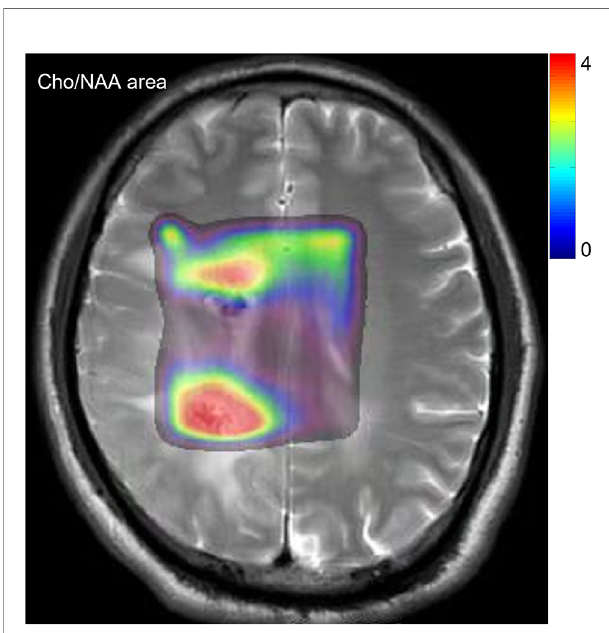
FIGURE 2 | An example of MRS with a distribution of